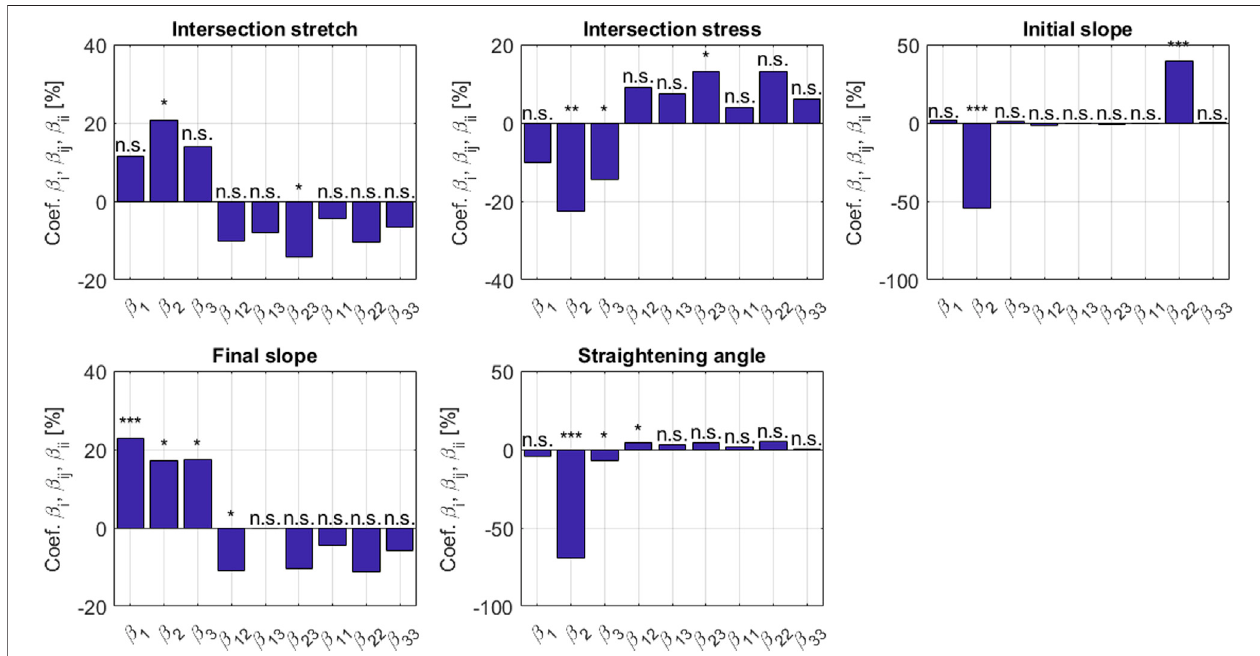
FIGURE 6 | Sensitivity coefficients β i , β ij , β ii according to Eqs 47 , 48 , with the indices 1, 2, and 3 relating to modulus, crimping angle, and volume fraction, respectively; determined for fi vemetrics Y associated with the uniaxial stress-stretch behavior on thelevel ofthe tendinous tissue. The stars denote the signi fi cance level of the coef fi cients: three (resp. two and one) stars for a p -value below 10 – 3 (resp. 10 – 2 and 0.05); n . s . stands for non signi fi cant.